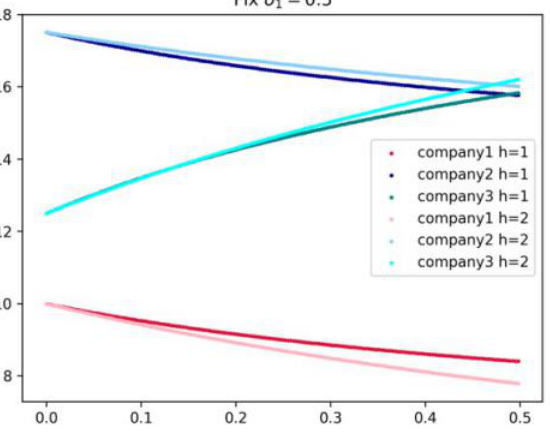
Figure 8. The result of the distribution of profits varies with δ 2 ( δ 1 is fixed). Among them, the horizontal axis represents the weight of change and the vertical axis represents the result of profit distribution. In each figure, the weight of one factor was fixed at 0.5 to change other weights, and the final profit distribution results were compared under the conditions of power being one and power being two. However, this experiment has given the specific values of three factors of three enterprises, so the experiment fails to reflect the influence of the power in the